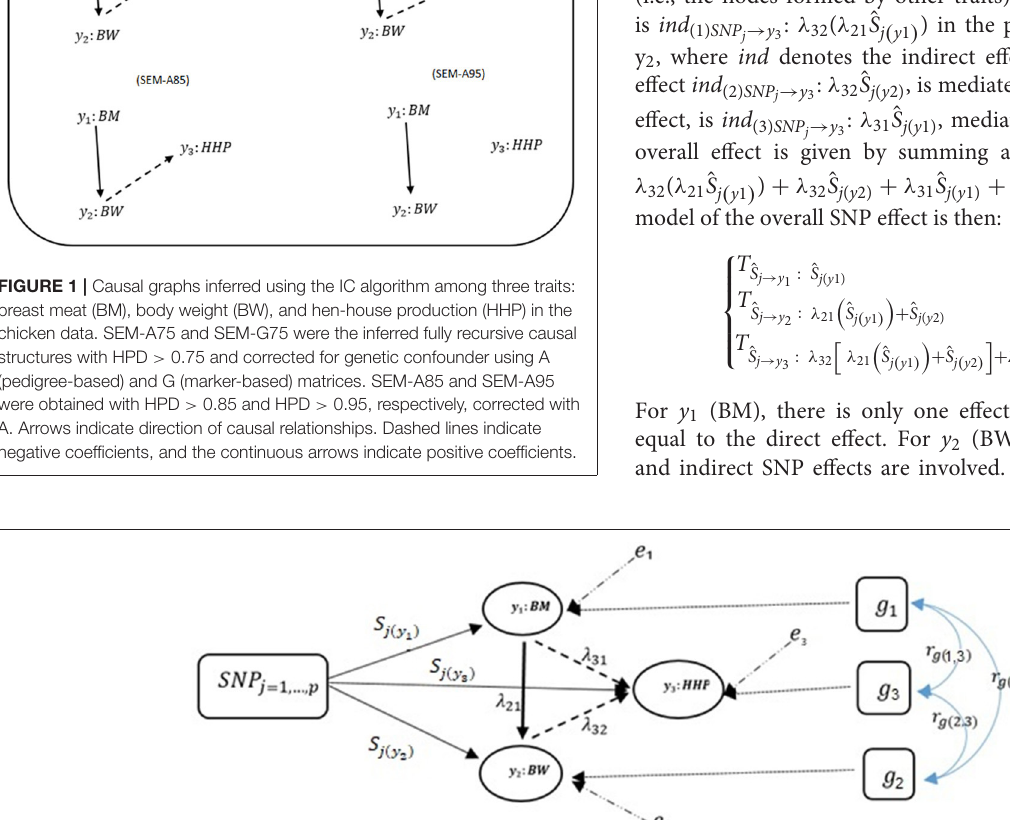
), and recursive effect of phenotype t ′ on t )